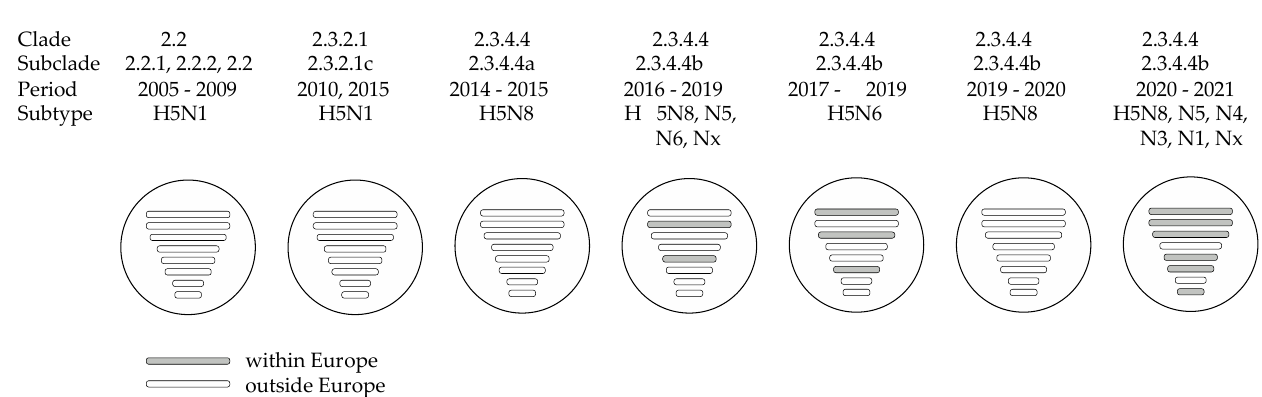
Figure 1. Highly pathogenic avian influenza H5 GsGd virus detections in wild birds and poultry in Europe, 2005–2020. Each panel shows the European countries in which the subclade had been detected, including the time period. Green, viruses detected in wild birds; orange, viruses detected in poultry; green-orange striped pattern, subclade detected in both wild birds and poultry at country level; light green, clade 2.2 viruses detected in wild birds and subclade unknown; light orange, clade 2.2 viruses detected in poultry and subclade unknown. References used [24,34,35,37–57].